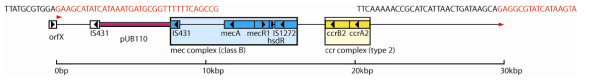
Schematic representation of the SCCmec element of CF-Marseille (Hx1203407144) showing combined structure built of part of SCCmec II and IV elements.